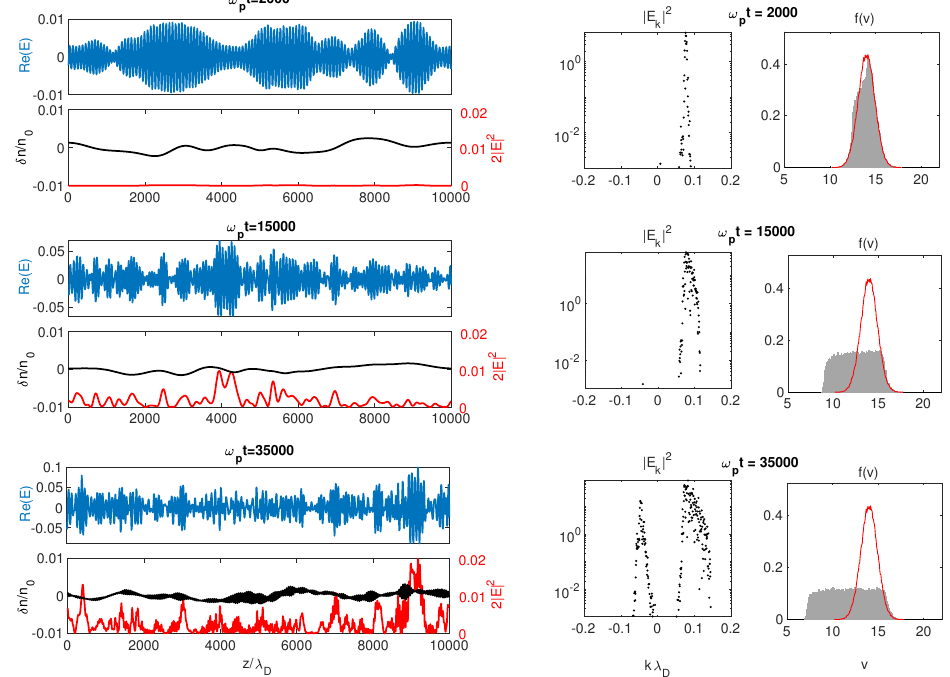
Figure 2. Beam dynamics’ and wave packet’s evolution at three moments of time, ω p t = 2000, 15,000 and 35,000 (from upper to lower rows). ( Left panels): Spatial profiles of the electric field envelope Re | E | (blue) and of the energy density 2 | E | 2 (red), superposed to the density fluctuations δ n / n 0 (black). ( Middle panels): Corresponding electric field spectra | E k | 2 in logarithmic scales. ( Right panels): Corresponding electron velocity distributions f ( v ) (grey surfaces), superposed to the initial distribution (red curves). Main parameters are the following: v b / v T = 14, ∆ v b / v b = 0.08, n b / n 0 (cid:39) 2.5 × 10 − 5 , ∆ n (cid:39) 0.001. All variables are normalized. (Reproduced by permission of the AAS